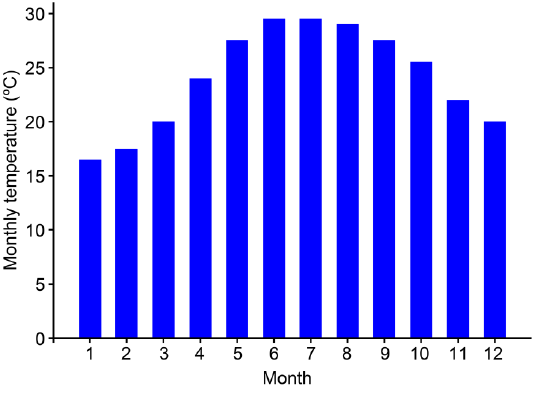
Figure 3. Mean monthly temperature (°C) in Hanoi